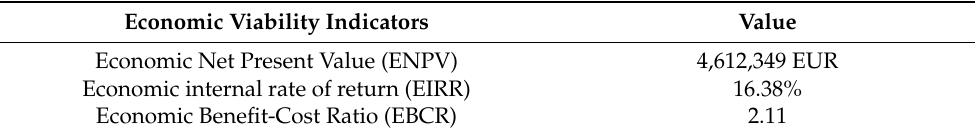
Table 14. An overview of the economic feasibility indicators of the WWTP